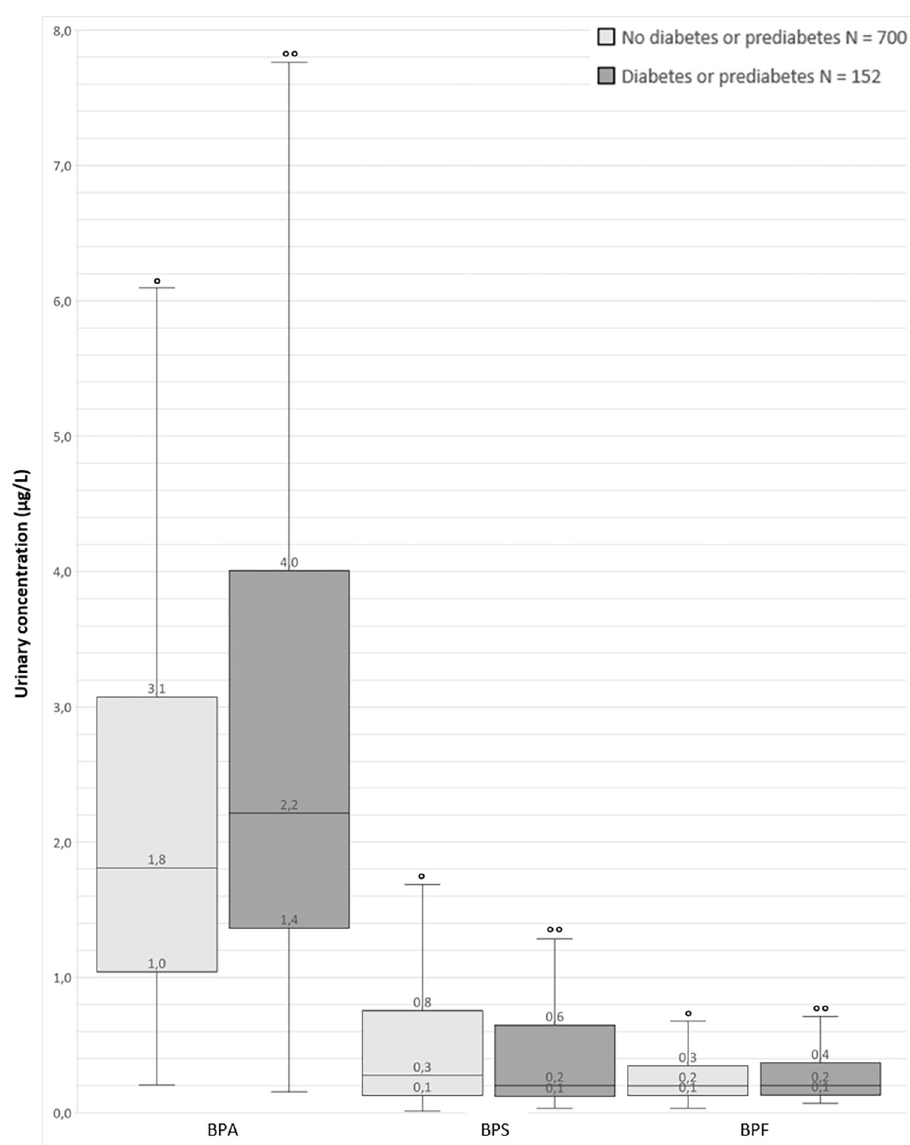
Fig 1. Description of urinary concentrations of bisphenols ( μ g/L) in the bisphenol population by boxplots. Within each box, horizontal black line denotes median value; boxes extend from the 1st to the 3rd quartile (= inter-quartile range IQR) of each group’s distribution of value. The ends of the extended vertical lines indicate the 1st quartile minus 1.5 times the IQR and the 3rd quartile plus 1.5 times the IQR; observations outside this range are not represented (BPA ˚ 59 observations > 6.1˚˚ 11 observations > 7.8 / BPS ˚ 80 observations > 1.7˚˚ 22 observations > 1.3 BPF ˚ 52 observations > 0.7˚˚ 15 observations > 0.7; no extreme low values were observed). BPA: bisphenol A, BPS: bisphenol S, BPF: bisphenol